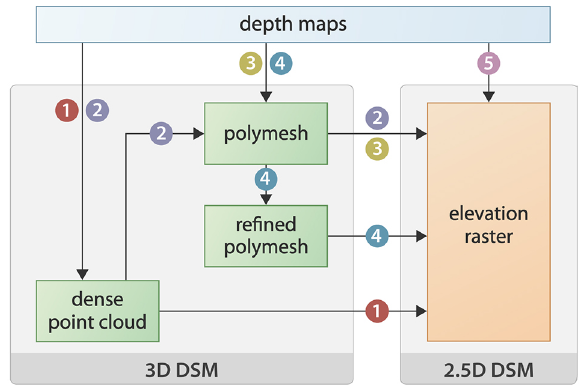
Figure 5 . The five relevant pathways one can follow in Agisoft Metashape Professional 1.7.1 to create a 2.5D raster DSM.